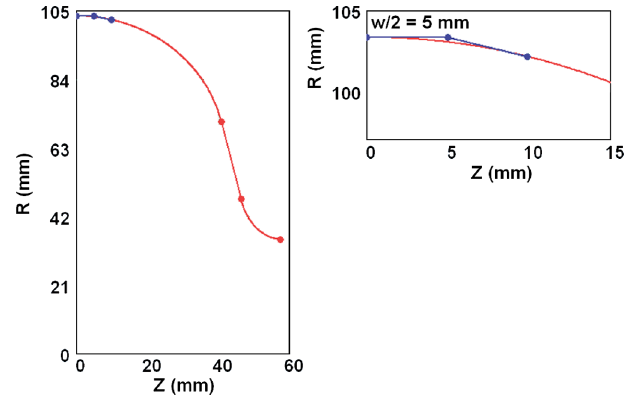
FIG. 12. Flat equator in the case of the TESLA cavity (blue